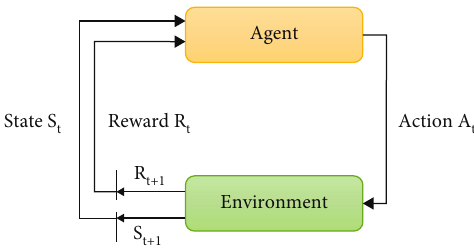
Figure 1: Schematic diagram of interaction between agent and